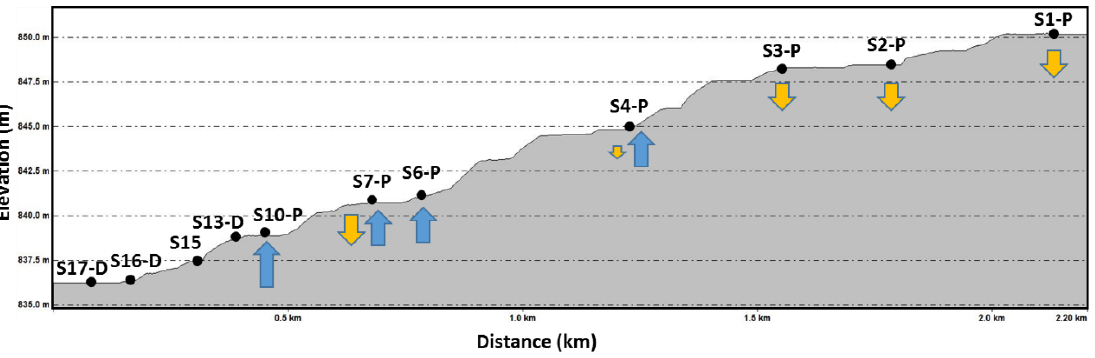
Figure 6. Streambed elevation profile along the study reach. The arrows indicate the direction and the approximate magnitude of the exchange process.